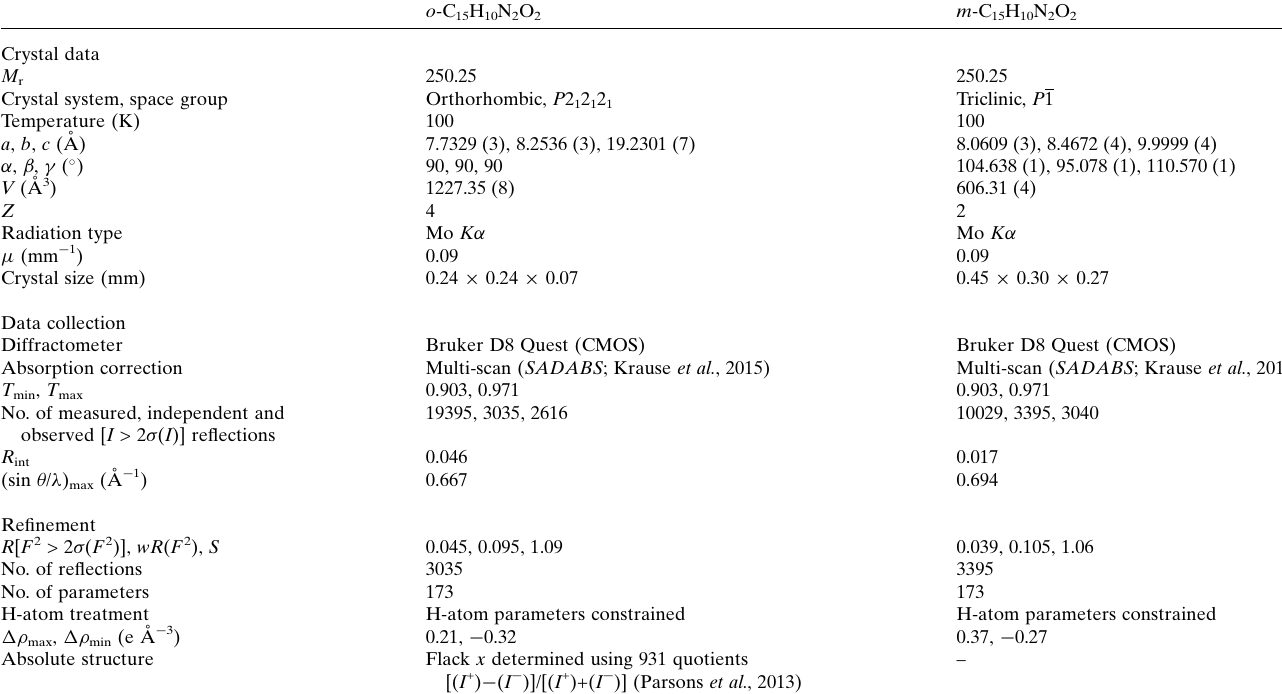
Table 3 Experimental